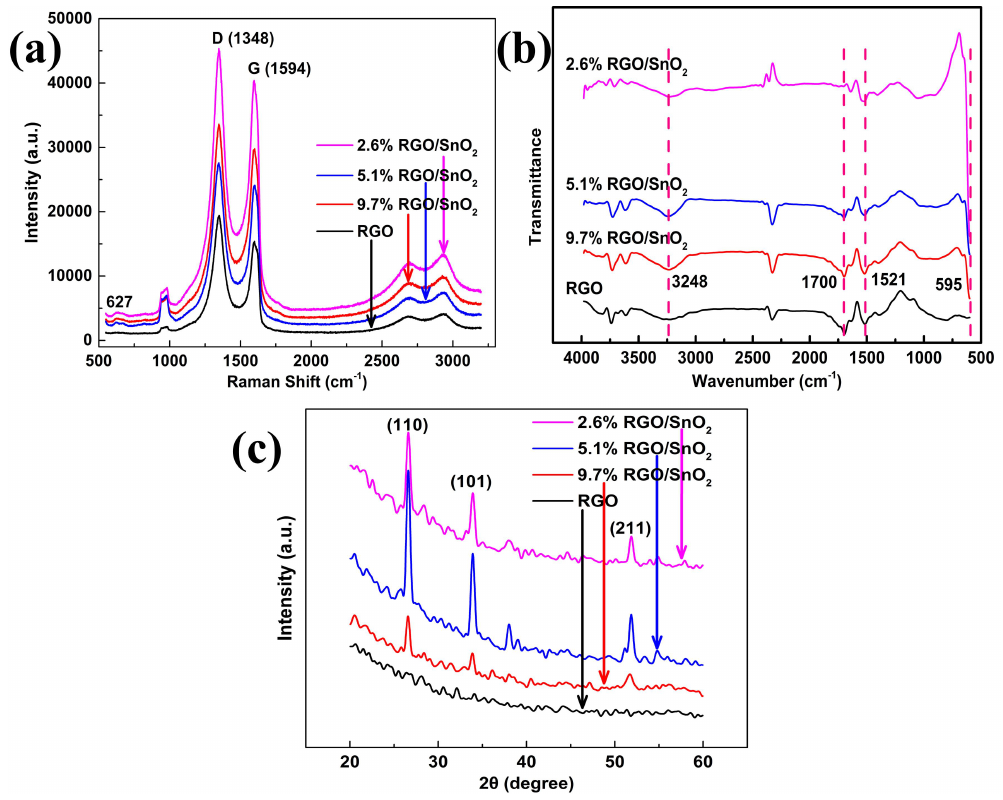
Figure 4. ( a ) Raman spectra. ( b ) FTIR spectra. ( c ) XRD